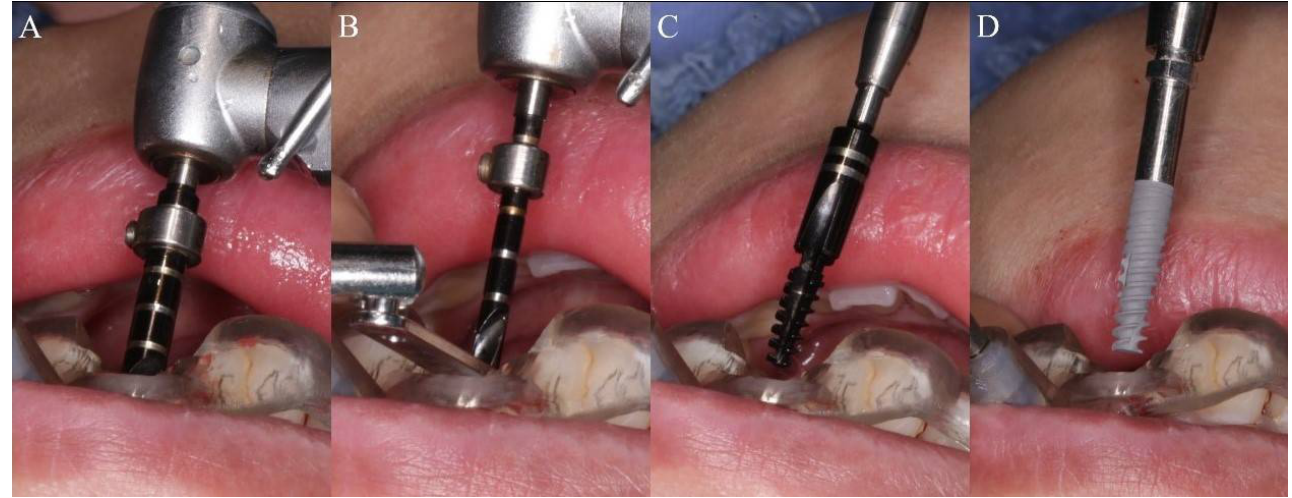
Figure 1. The sequence of the drill in immediate implantation protocol: ( A ) Remove the resistance of the lingual/palatal bone wall with a large-diameter guided twist drill; ( B ) Preparation with sequential guided twist drills and corresponding guided drill guides under the guidance of the template; ( C ) Tapping with guided screw tap; ( D ) Implant insertion.